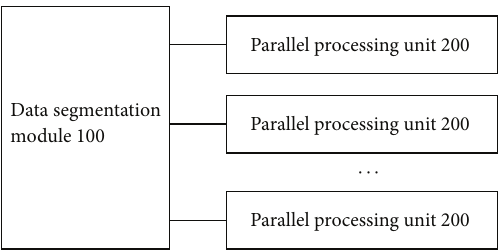
Figure 4: Model of adjacent zero communication parallel cloud computing system.